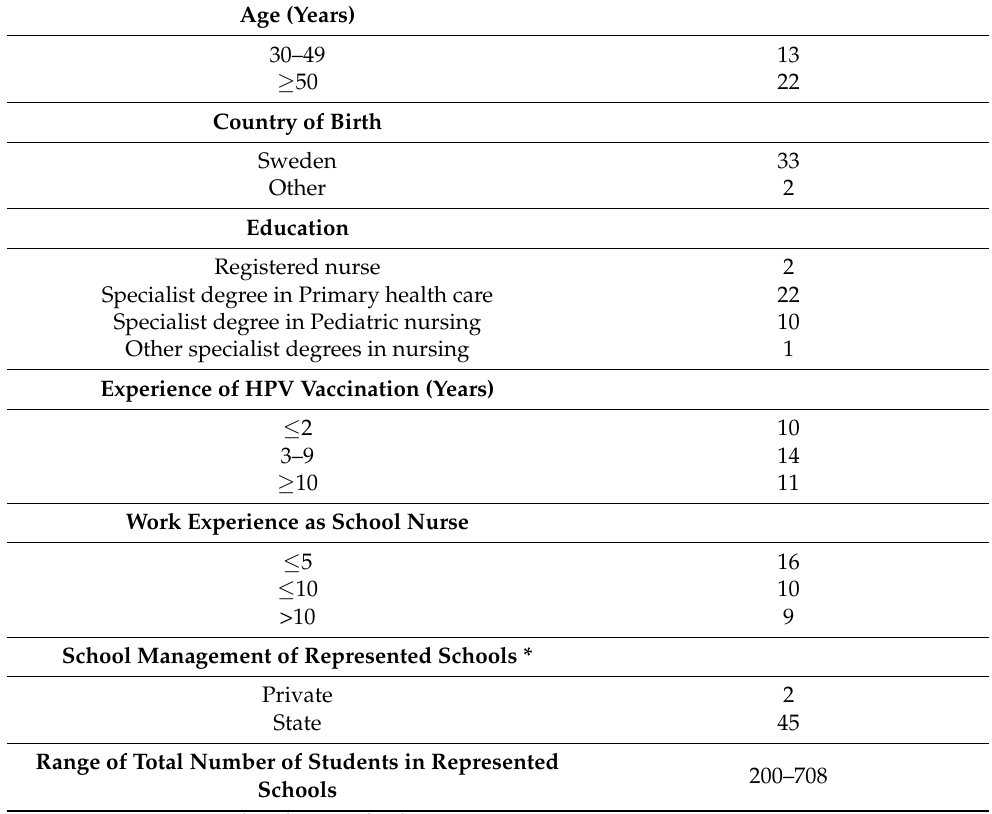
Table 2. Participants’ characteristics ( n =